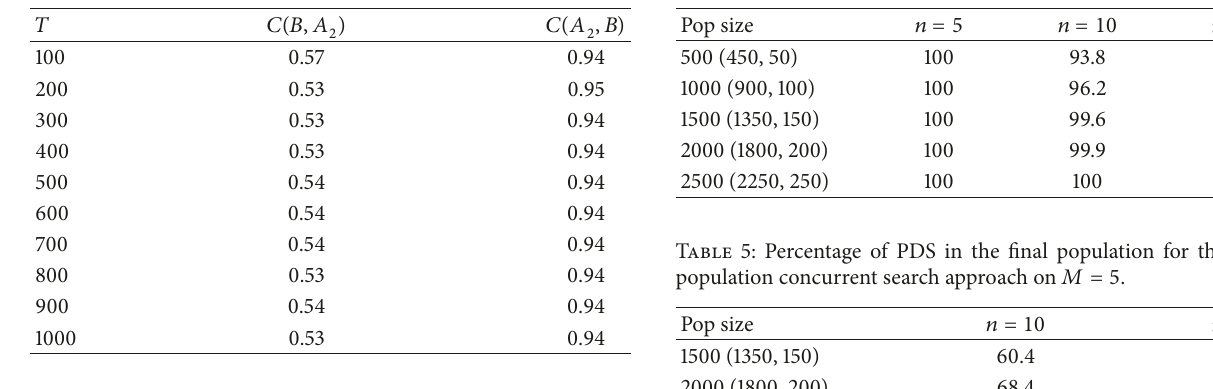
Table 4: Percentage of PDS in the final population for the two- population concurrent search approach on 𝑀 = 4 .